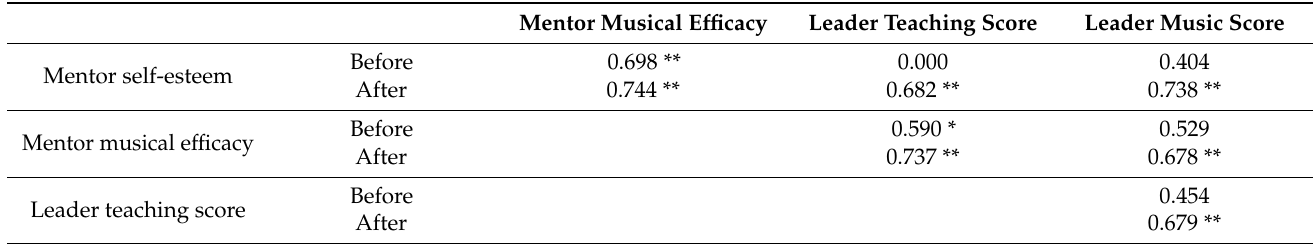
Table 2. Spearman rank-order correlations between the four measures. Mentor Musical Efficacy Leader Teaching Score Leader Music Score Mentor